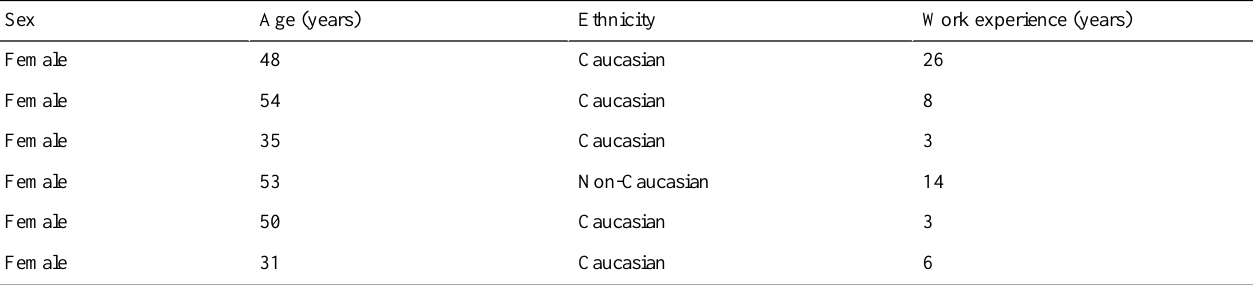
Table 2. Characteristics of participants: maternity care assistants (MCAs).